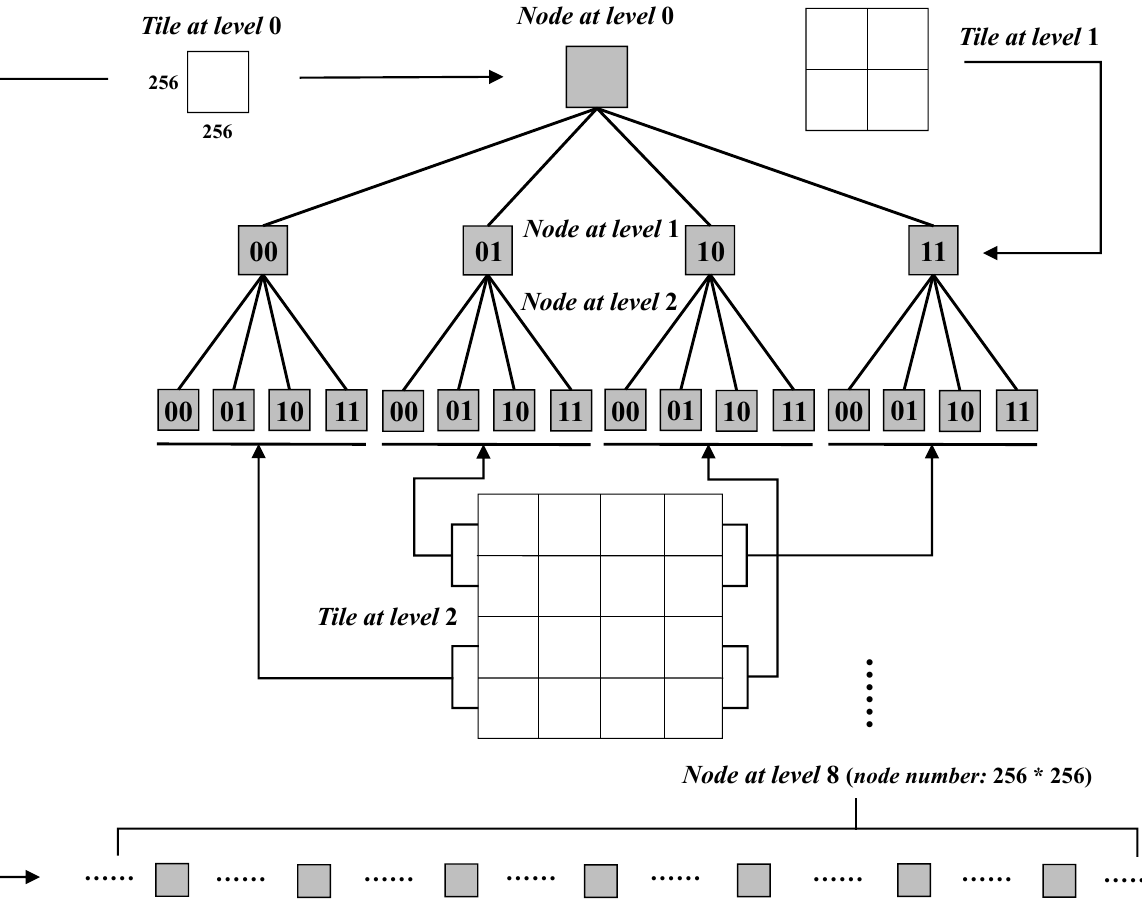
Figure 5. The corresponding relationship between TQ-tree node, coding, and spatial range of tile. The design of the TQ-tree structure can realize efficient data pre-processing and rapid visualization of large-scale vector data. Firstly, compared with the R-tree indexing techniques, the data insertion during the quadtree index construction has little effect on the construction speed. Secondly, if the node is created only when it intersects any vector object, the problem of determining whether the spatial range of a pixel intersects any vector object can be converted to the issue of whether the node exists or not, this is based on the characteristics of nodes. When the spatial range of a pixel is taken as the retrieval range, the retrieval range will not intersect with the node index range, so there will be no multiple judgment paths. By coding the spatial range of the tiles/pixels, the corresponding node can be quickly located by the unique encoding of a tile/pixel, which can be achieved by simple string manipulation with minimal computational